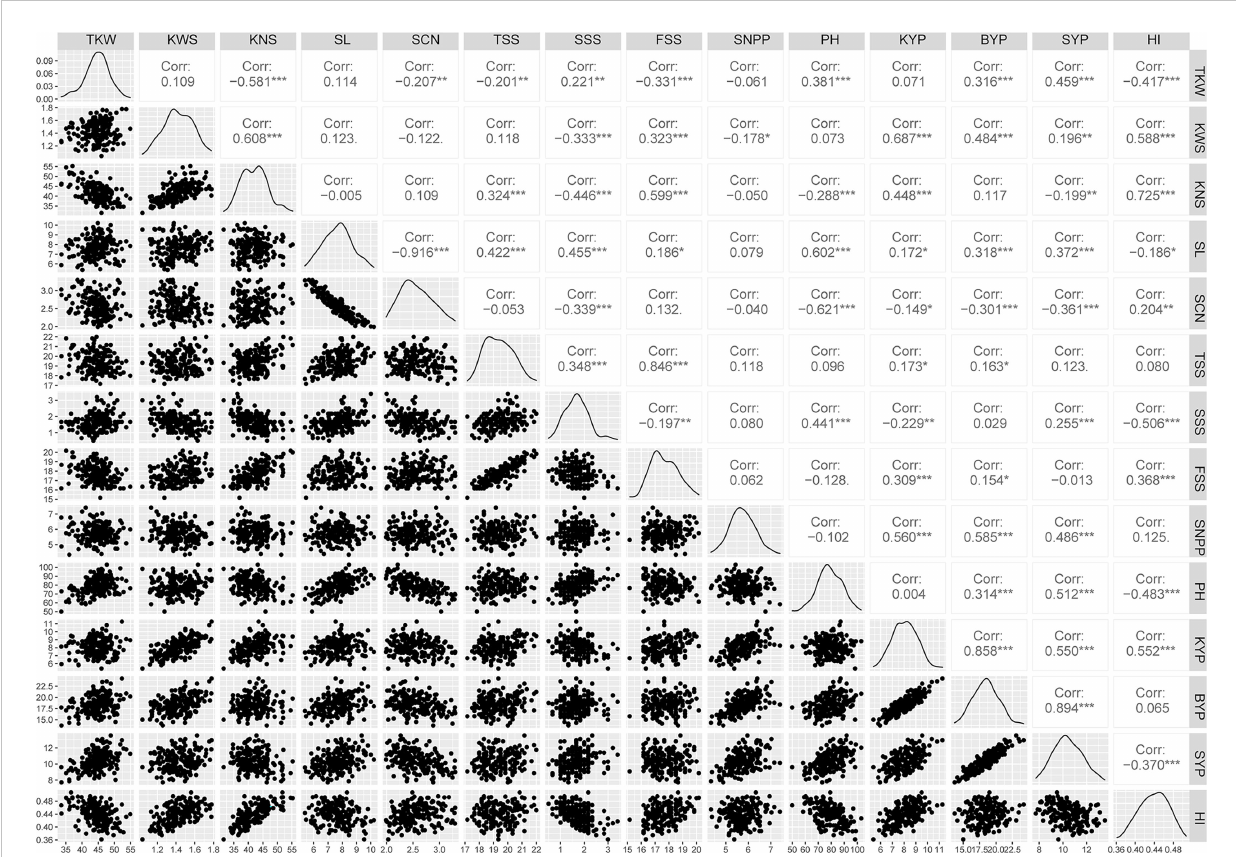
FIGURE 2 Correlation coef fi cients among yield-related traits of Xiaoyan 54/Jing 411 RIL population in six environments. Note: TKW, KWS, KNS, SL, SCN, TSS, SSS, FSS, SNPP, PH, KYP, BYP, SYP and HI are the same as Table 2; *, ** and *** indicate signi fi cant at 0.05, 0.01 and 0.001 levels,